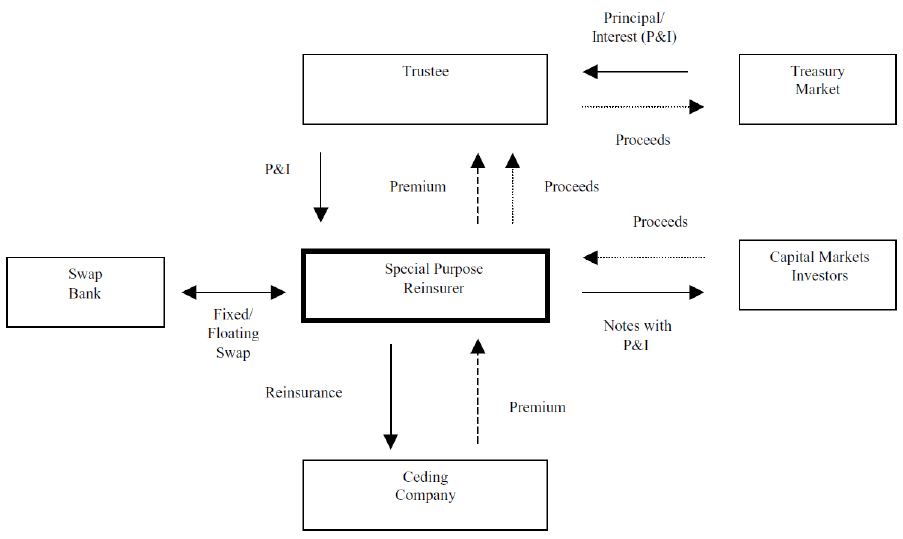
Figure 2-The standard catastrophe bond